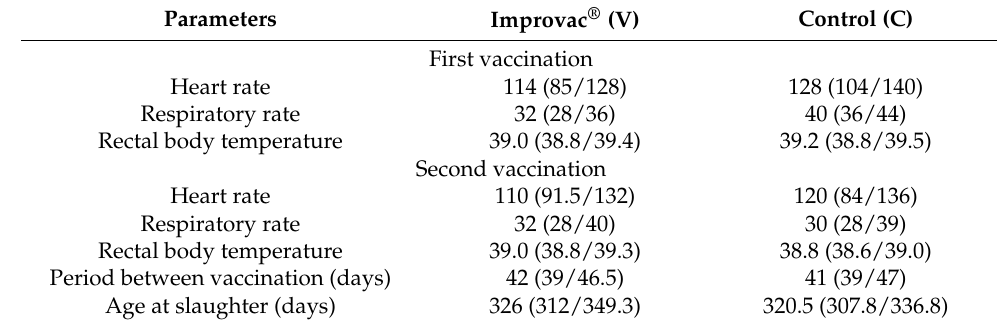
Table 1. Heart rate in beats/min; respiratory rate in breaths/min; rectal body temperature in ◦ C. Age at slaughter of n = 32 slaughtered calves available. Median values are indicated with 25%/75% quartiles in